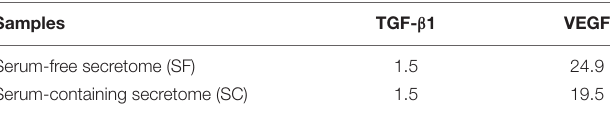
TABLE 1 | The concentration of growth factors in ADSC-derived secretome (ng/ml). Samples TGF- β 1 VEGF Serum-free secretome (SF) Serum-containing secretome